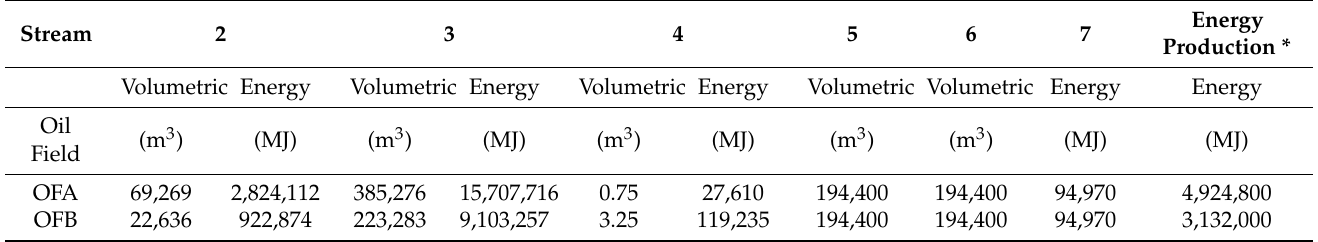
Table 5. Input sources for the geothermal energy co-production